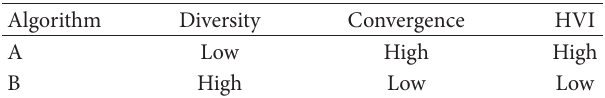
Table 2: Comparison of solution sets produced by Algorithms A and B.